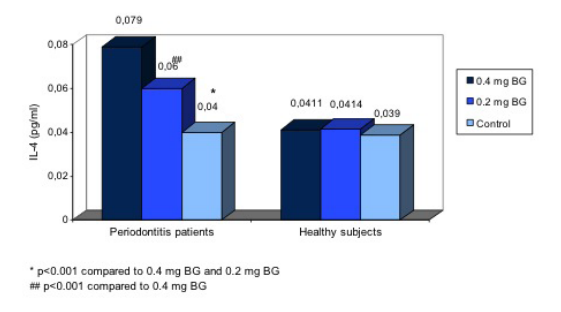
Figure 1. Comparison of IL-4 levels in stimulated leukocyte medium within periodontitis patient and healthy subject groups.